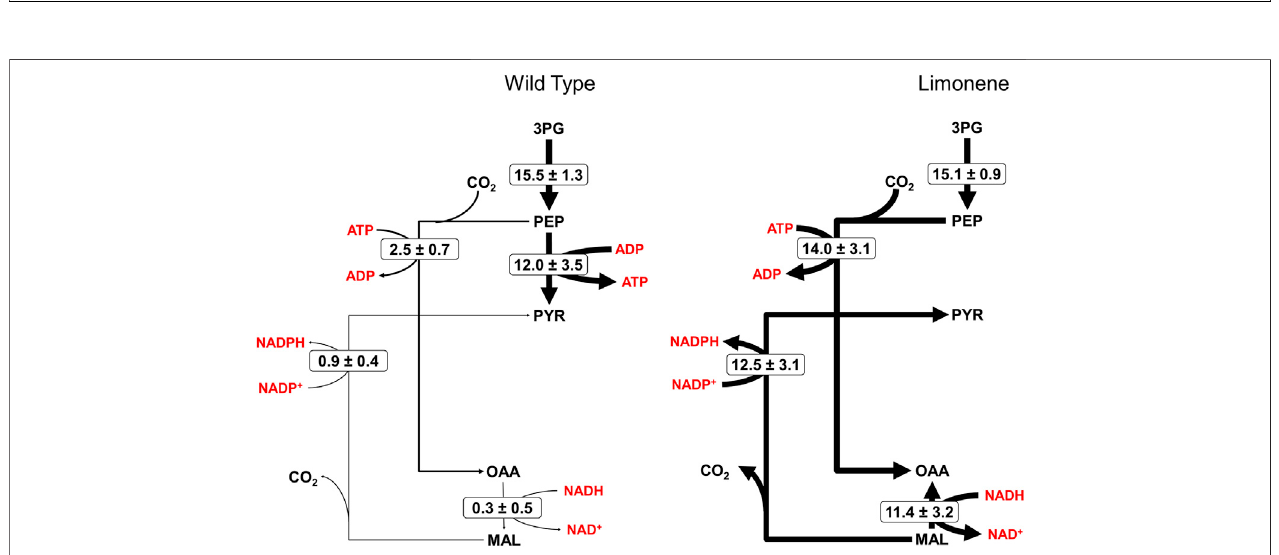
FIGURE 3 | Fluxes of pyruvate synthesis from phosphoenolpyruvate. The fl ux distribution between the one-step, pyruvate kinase mediated reaction from PEP to PYR versus the three-step amphibolic pathway, involving phosphoenolpyruvate carboxylase, malate dehydrogenase, and the malic enzyme differ signi fi cantly between WT andLSstrains. Energymoleculecofactorsaidingineachreaction aredepictedinred.Thicknessoftheblackarrowsisproportionaltorelative fl ux values,provided in the form M ± SE where M is the calculated fl ux and SE is the standard error of the 95% con fi dence interval.